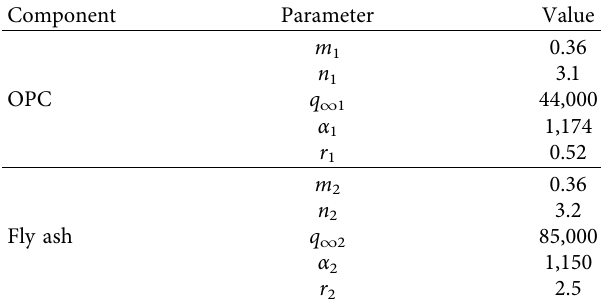
Figure 3: Illustration of components from a PFC-stabilized soil and definition of symbols used in the current study (PFC, Portland-fly ash cement; M s is the mass of solid soil in natural soil; M c is the mass of cement in blinder slurry; M F is the mass of fly ash in blinder slurry; M w is the mass of water in blinder slurry). the mass of water in natural soil; and M w 2 Table 1: Summary of parameters in equation